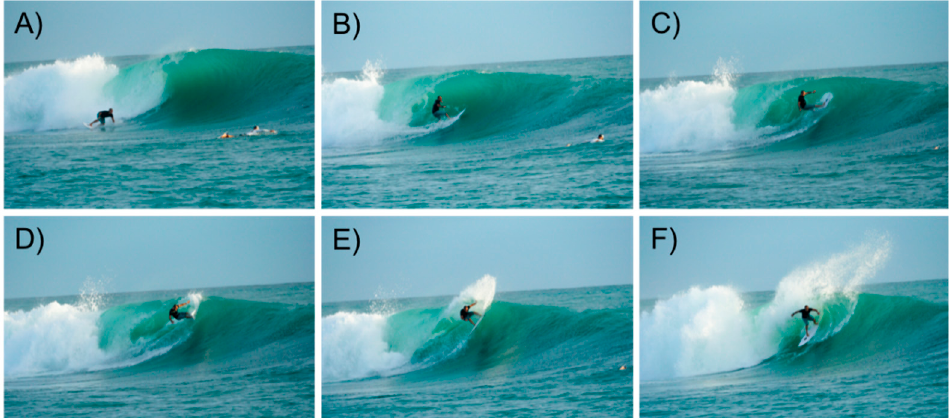
Figure 1. Image sequence showing a surfer (Dylan Perese) transitioning from a bottom turn to a cutback (also known as top turn). ( A ) bottom turn, ( B ) climbing the wave, ( C ) setting up the cutback, ( D , E ) performing the cutback, and ( F ) descending the wave. Photo credit: David “IndoEye”